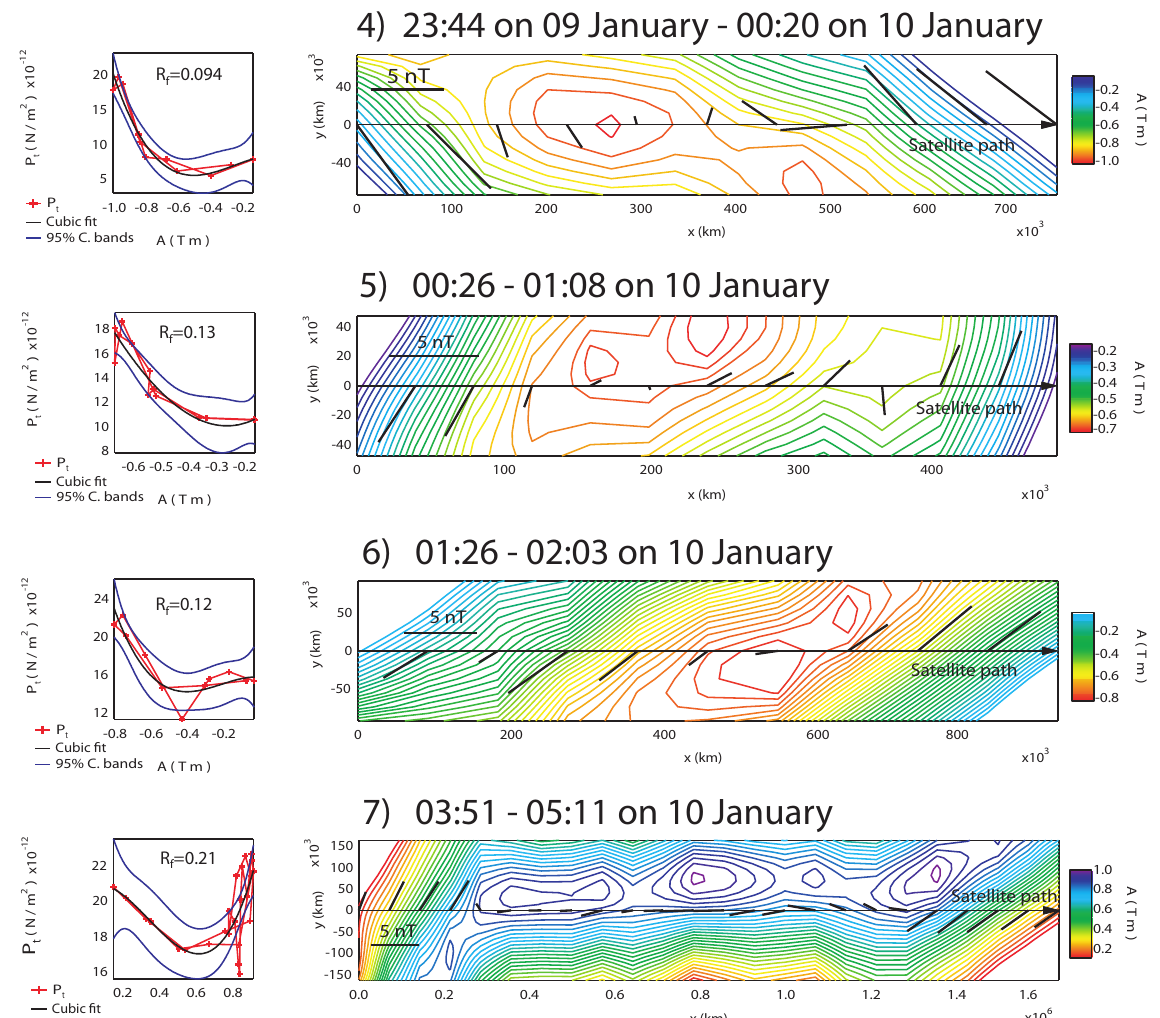
Fig. 3. The results of Grad–Shafranov reconstruction for the structures highlighted with blue-shaded areas in Fig. 1. The format is the same as Fig.